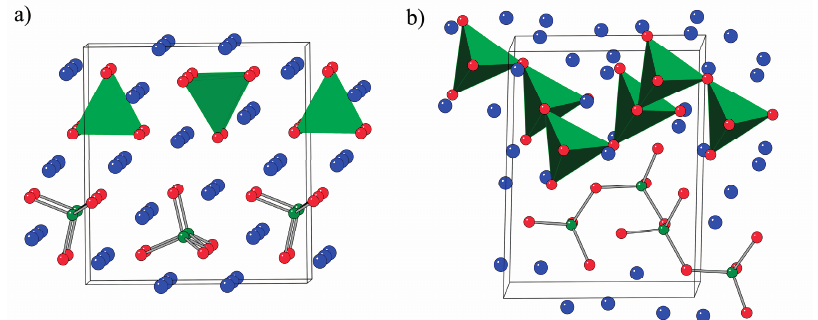
Figure 2. ( a ) Combined ball-and-stick and polyhedral representation of the crystal structure of Ca 3 AlAs 3 (space group Pnma ) and ( b ) Sr 3 GaSb 3 (space group P 2 1 /c ), both viewed approximately down the b direction. The blue circles are the Ca or Sr atoms, the green circles denote the Al or Ga atoms, and the red circles are the pnictogen atoms. The unit cells are outlined by solid black lines.